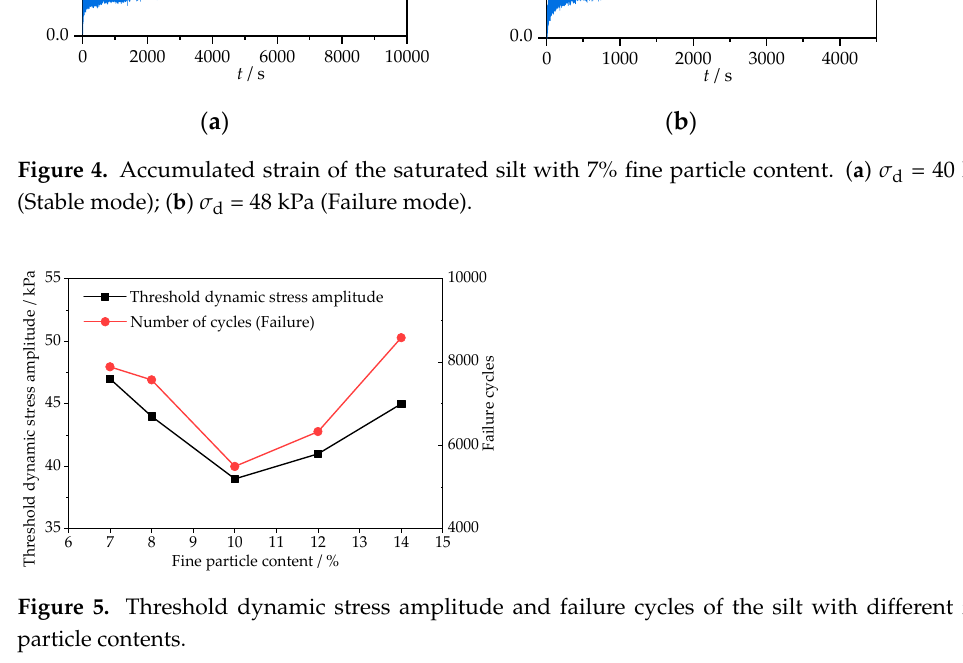
Figure 4. Accumulated strain of the saturated silt with 7% fine particle content. ( a ) σ d = 40 kPa (Sta ‐ ble mode); ( b ) σ d = 48 kPa (Failure mode).